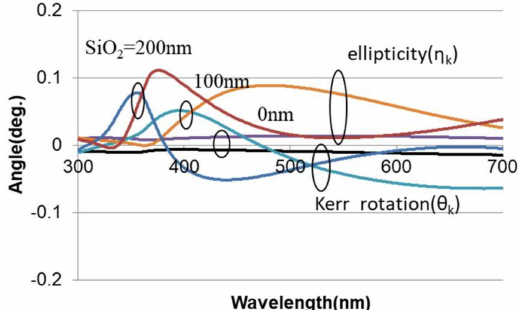
Figure 5. Simulated magneto-optical Kerr spectra of the sample A deposited on the SiO 2 under layer with thicknesses of 0, 100 and 200 nm. Black, blue, and dark blue lines show Kerr rotation θ K and purple, orange and red lines show ellipticity η K